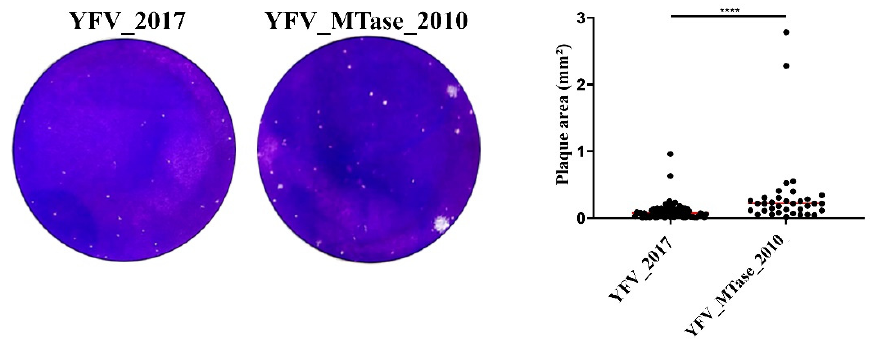
Figure 3. YFV_2017 and YFV_MTase_2010 plaque phenotype determination by area measurements. Red lines represent the area median value. Plaque areas were measured in ImageJ software, plotted in GraphPad Prism 8, and compared by Mann–Whitney test. **** represents the statistical significance of p < 0.0001.